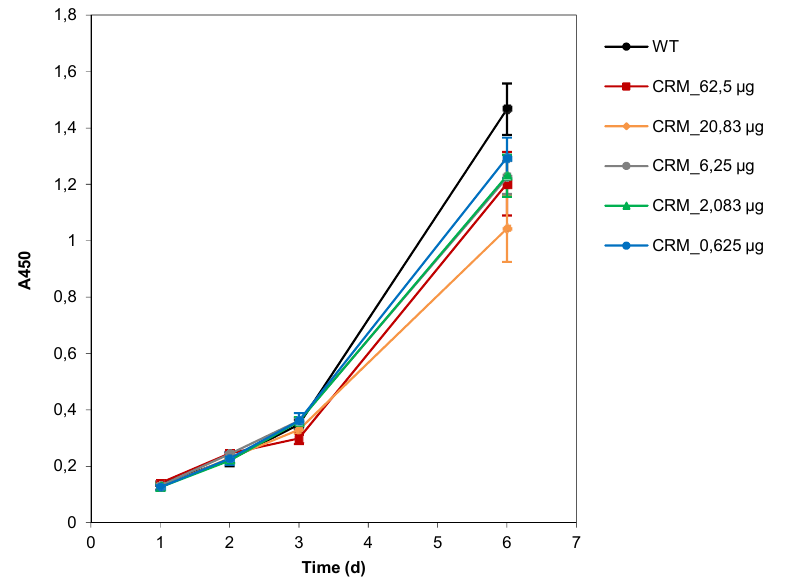
Figure 5 . Proliferation of gliobastoma cells treated with CRM197 peptide. Cell proliferation of untreated U87 glioblastoma cells (WT; black line) compared to cells treated with different amounts of CRM197 (colored lines). The viability of cells was determined using the cell proliferation reagent WST-1 and the absorbance was measured at 450 nm.